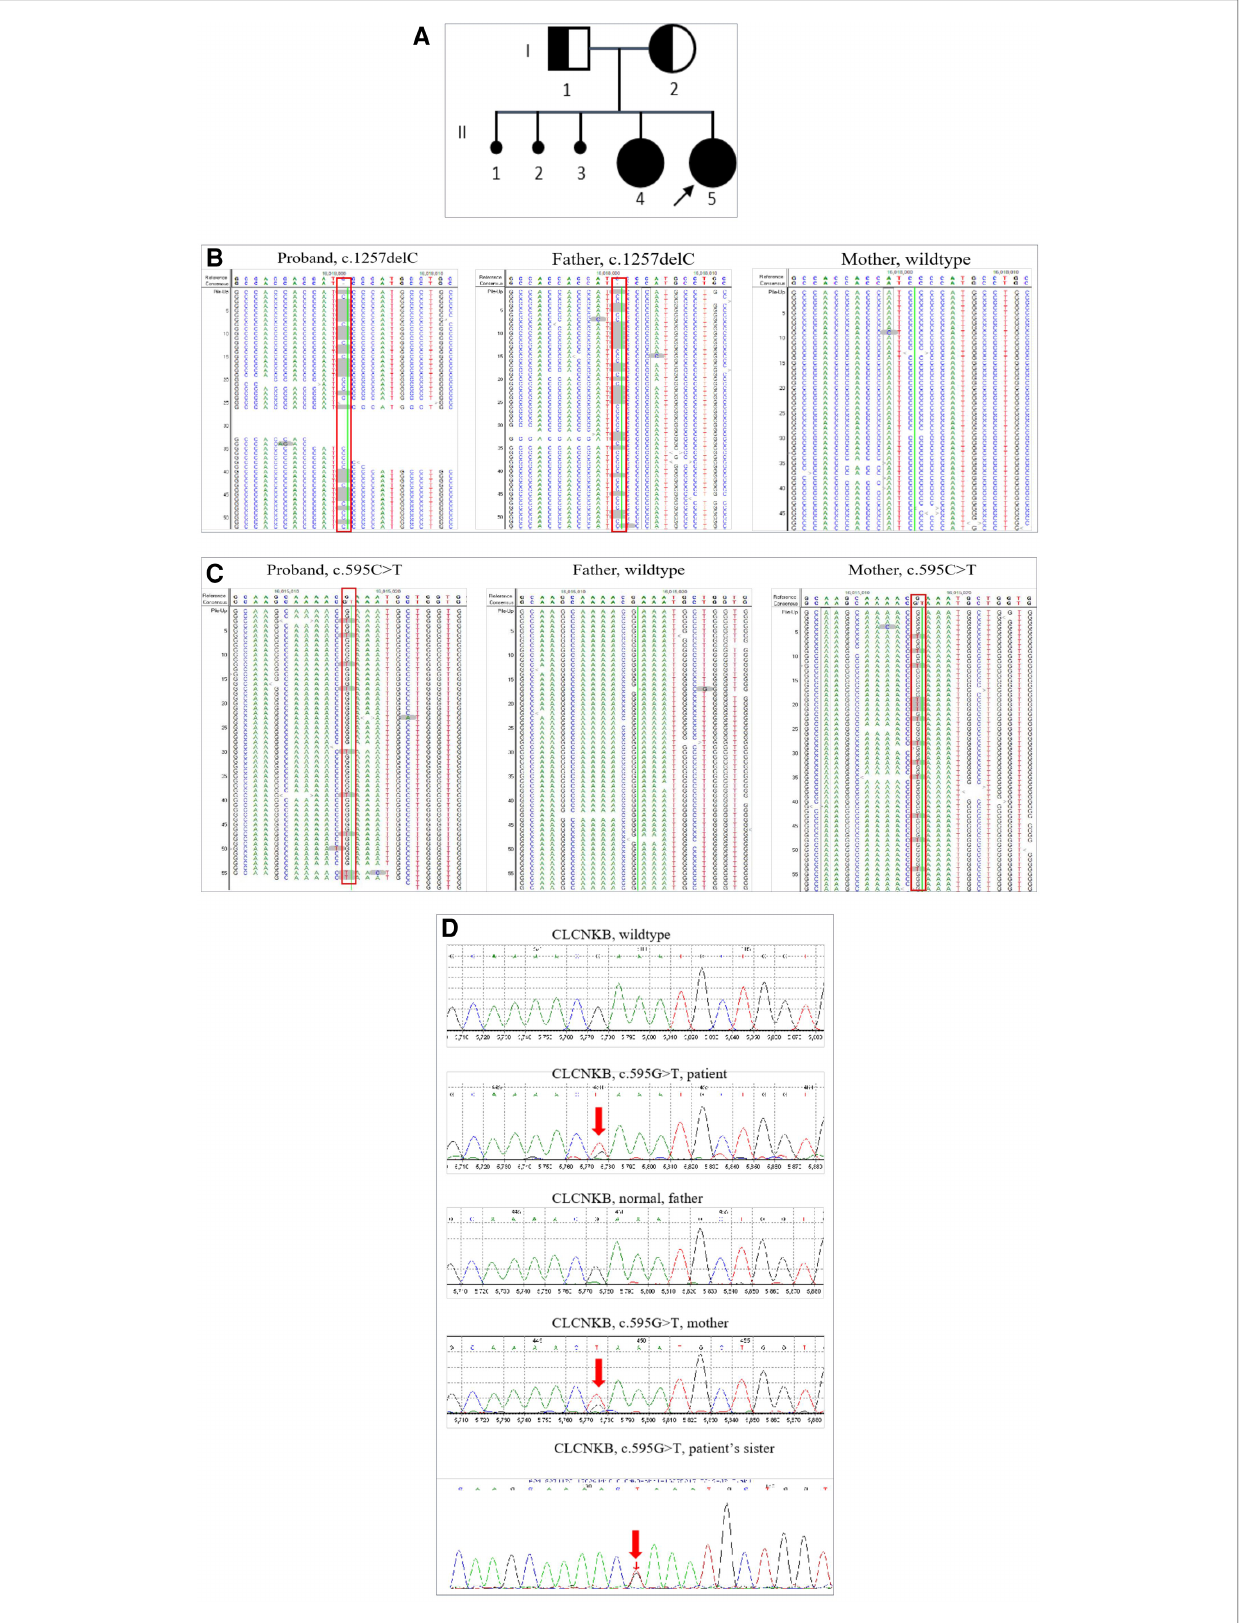
FIGURE 1 Pedigree of the patient family and Sanger analysis for the mosaic mutation in CLCKNB . ( A ) II 2 indicates the patient, I 1 and I 2 indicate the patient ’ s parents; both carried a heterozygous mutation of the CLCNKB gene, II 1 indicates the patient ’ s elder sister with similar clinical symptoms. ( B ) Next-generation sequencing detected c.1257delC in the CLCNKB gene in the patient and her parents. ( C ) Next-generation sequencing detected c.595G>T in the CLCNKB gene in the patient and her parents. ( D ) Sanger sequencing to con fi rm the mutation of the CLCNKB gene c.595G>T (p.E199*) in the patient ’ s